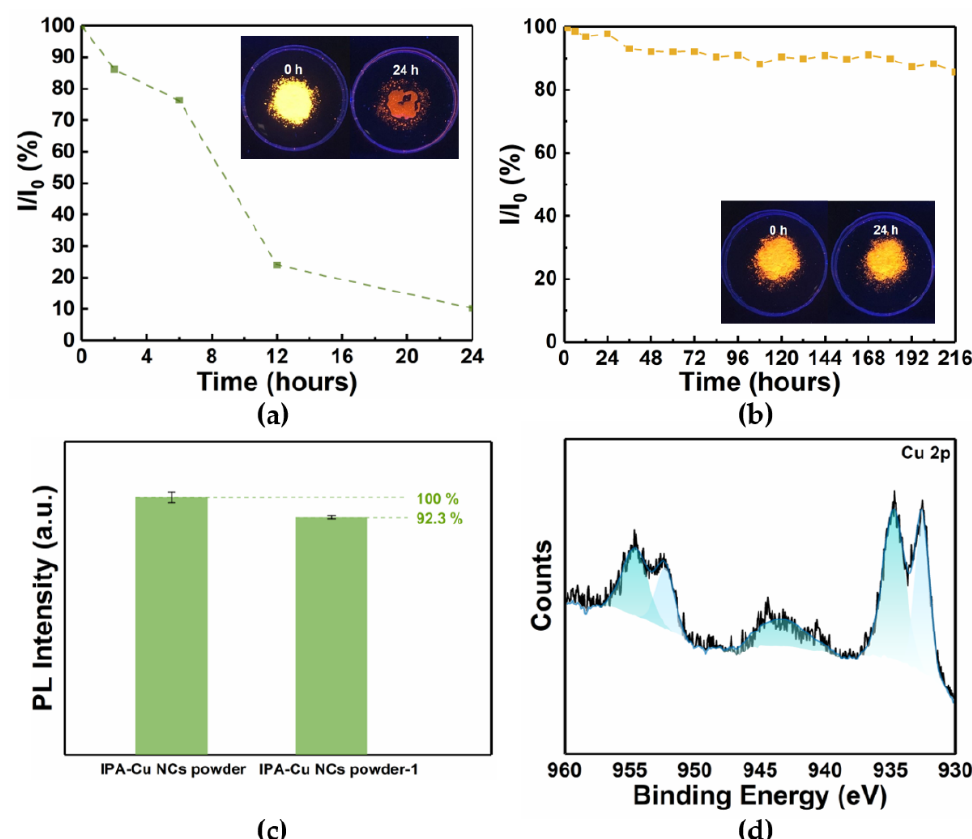
Figure 2. ( a ) PL intensity ratios (I/I 0 , I and I 0 represented PL intensity after different hours and initial PL intensity, respectively) of IPA-Cu NCs powder at the detection wavelength of 605 nm (365 nm excitation); ( b ) PL intensity ratios (I/I 0 , I and I 0 represented PL intensity after different hours and initial PL intensity respectively) of Ce-Cu NCs powder at the detection wavelength of 605 nm (365 nm excitation); ( c ) initial PL intensity of IPA-Cu NCs powder and PL intensity of IPA-Cu NCs powder-1 at the detection wavelength of 605 nm; ( d ) XPS spectrum of Cu 2p electrons of IPA-Cu NCs powder-1. Insets in ( a , b ) show photographs under UV light of IPA-Cu NCs powder and Ce-Cu NCs powder stored under the ambient humidity of 75% and temperature of 25 ◦ C after 24 h.